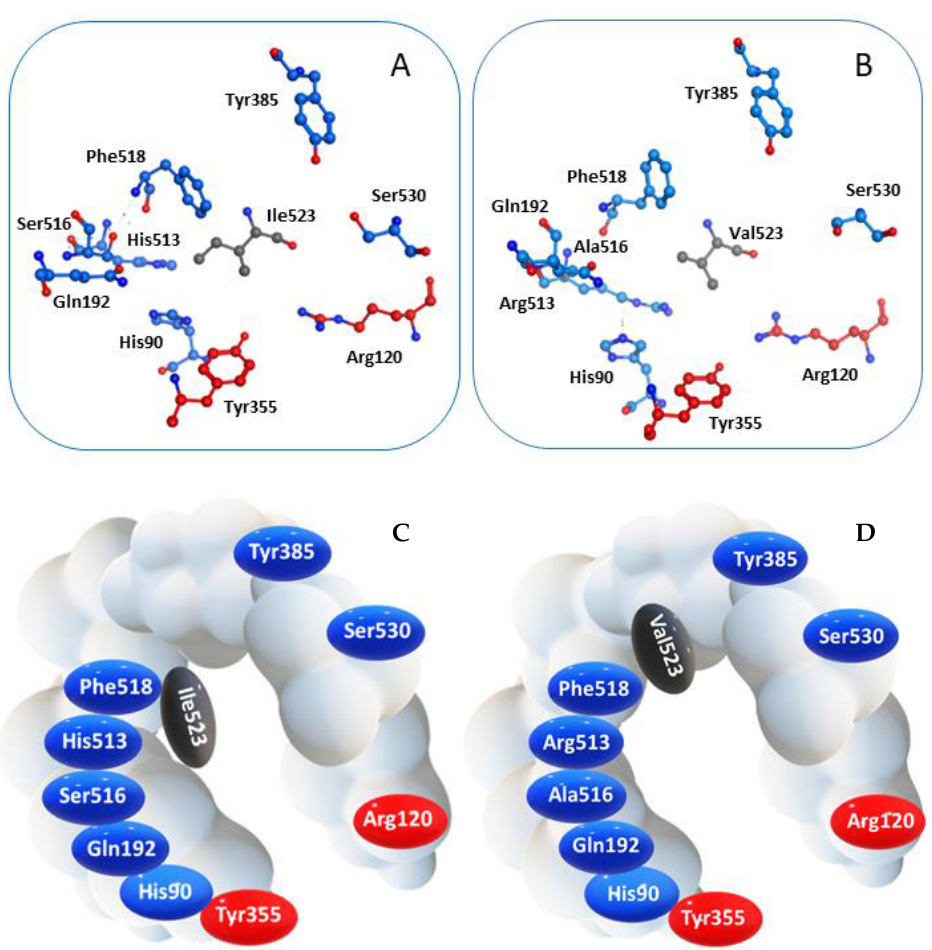
Figure 2. Spatial arrangement of key residues in the binding pocket of ( A ) COX-1 and ( B ) COX-2, and corresponding schematic representation highlighting the different wideness of the catalytic cavity of the two enzyme isoforms ( C ) COX-1 and ( D ) COX-2.